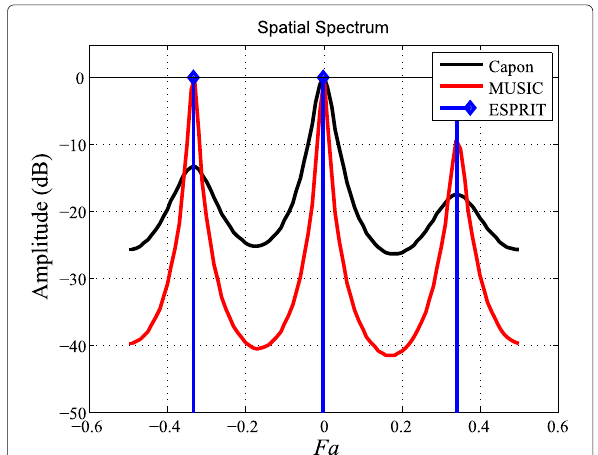
Fig. 12 Envelopes of spatial spectrum achieved by different estimation methods for the real airborne four-multichannel